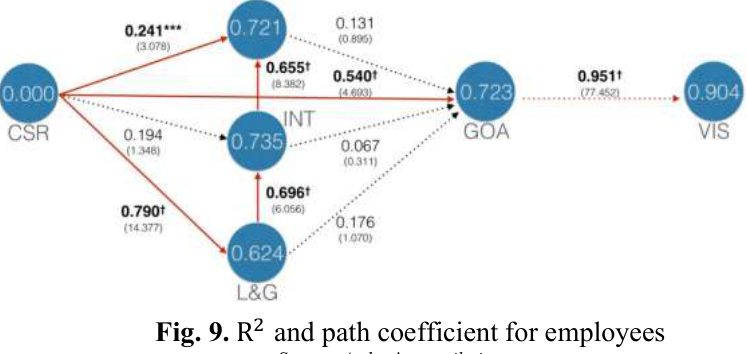
Fig. 9. R (cid:2870) and path coefficient for employees